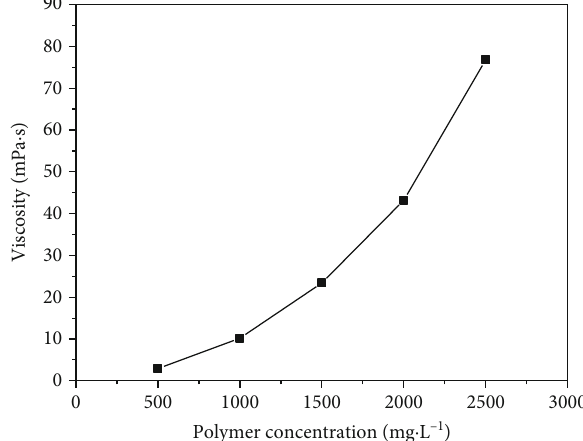
Figure 4: The viscosity of polymer solution versus polymer